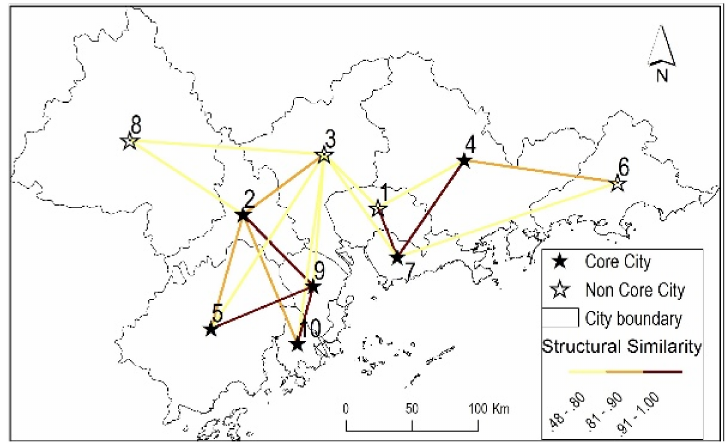
Figure 3. The structural similarity and core nodes in the sample train